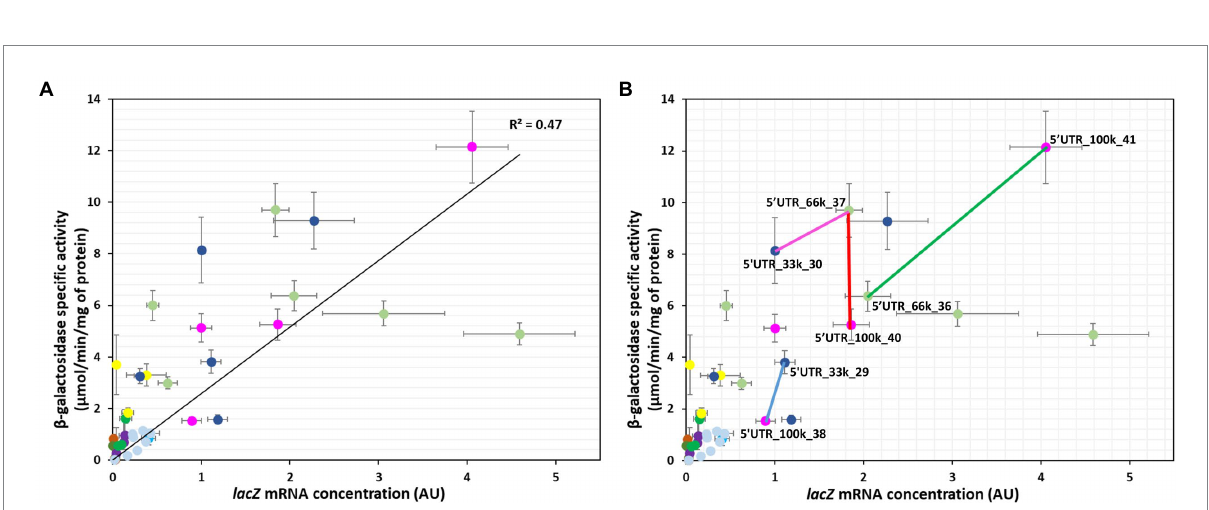
FIGURE 3 Relationships between β -galactosidase activity and lacZ mRNA concentration for the 41 constructs. mRNA concentrations are expressed as fold changes relative to the reference strain (5’UTR_33k_30). (A,B) Correlation between protein and mRNA levels (the black line represents the linear regression line, R 2 = 0.47). The colored lines in part (B) highlight examples in which differences in protein levels are mainly due to translation regulation (red), mainly due to mRNA concentration regulation (green), or due to a combination of translation and mRNA concentration regulation acting codirectionally (blue) or in opposite directions (pink). Error bars represent standard deviations ( n =